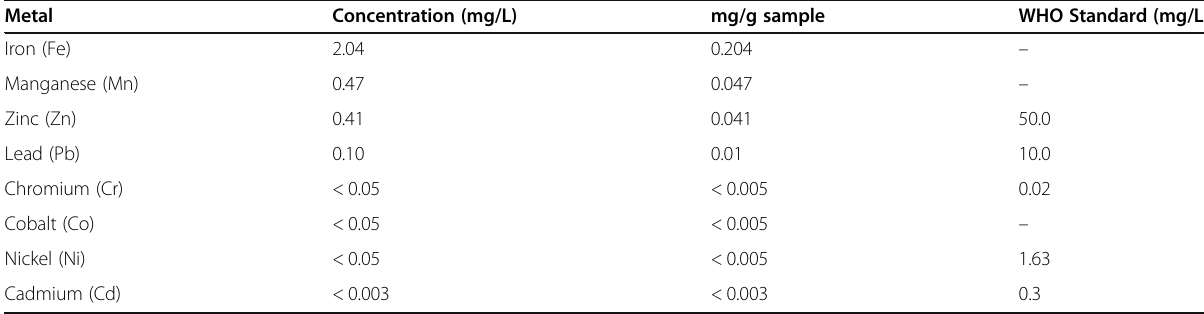
Table 2 Concentration of different heavy metal (mg/L) in a plant sample with WHO